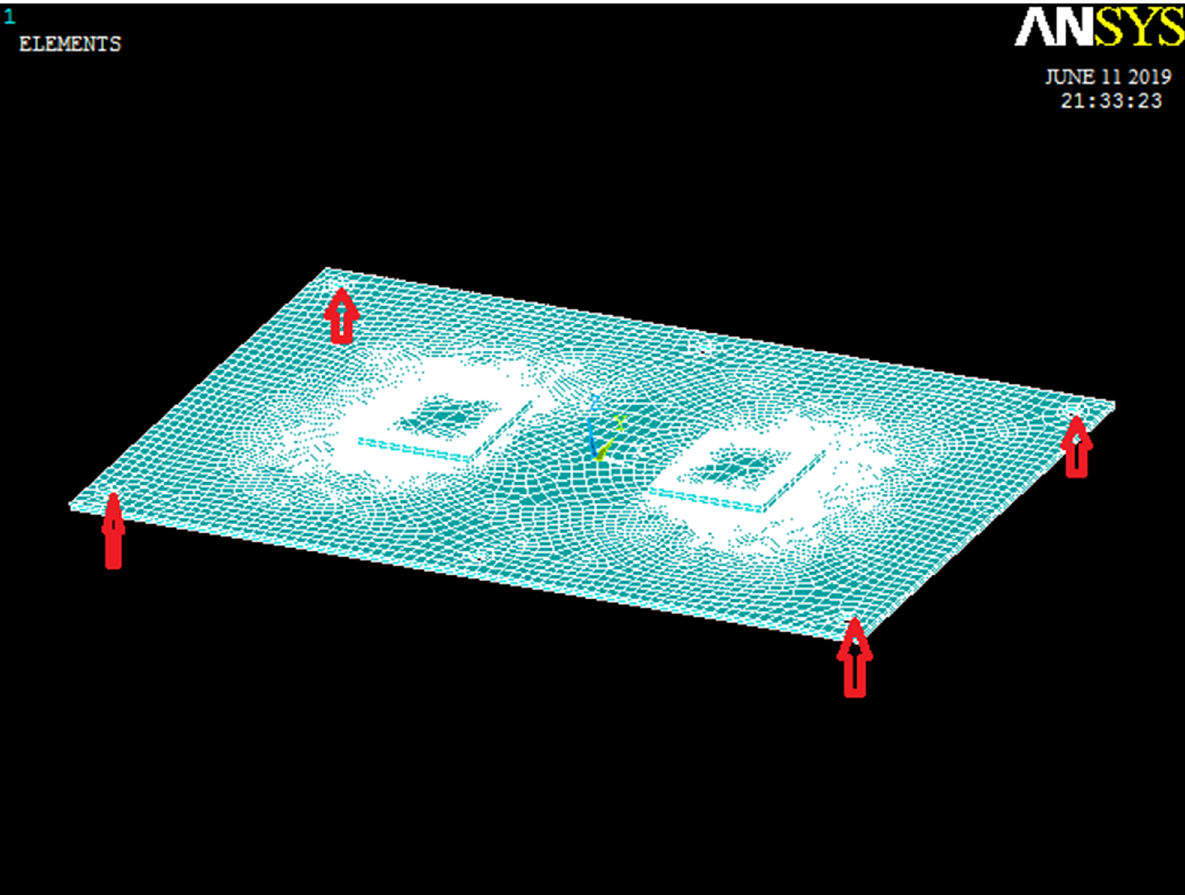
Fig. 10. Input PSD given at 4